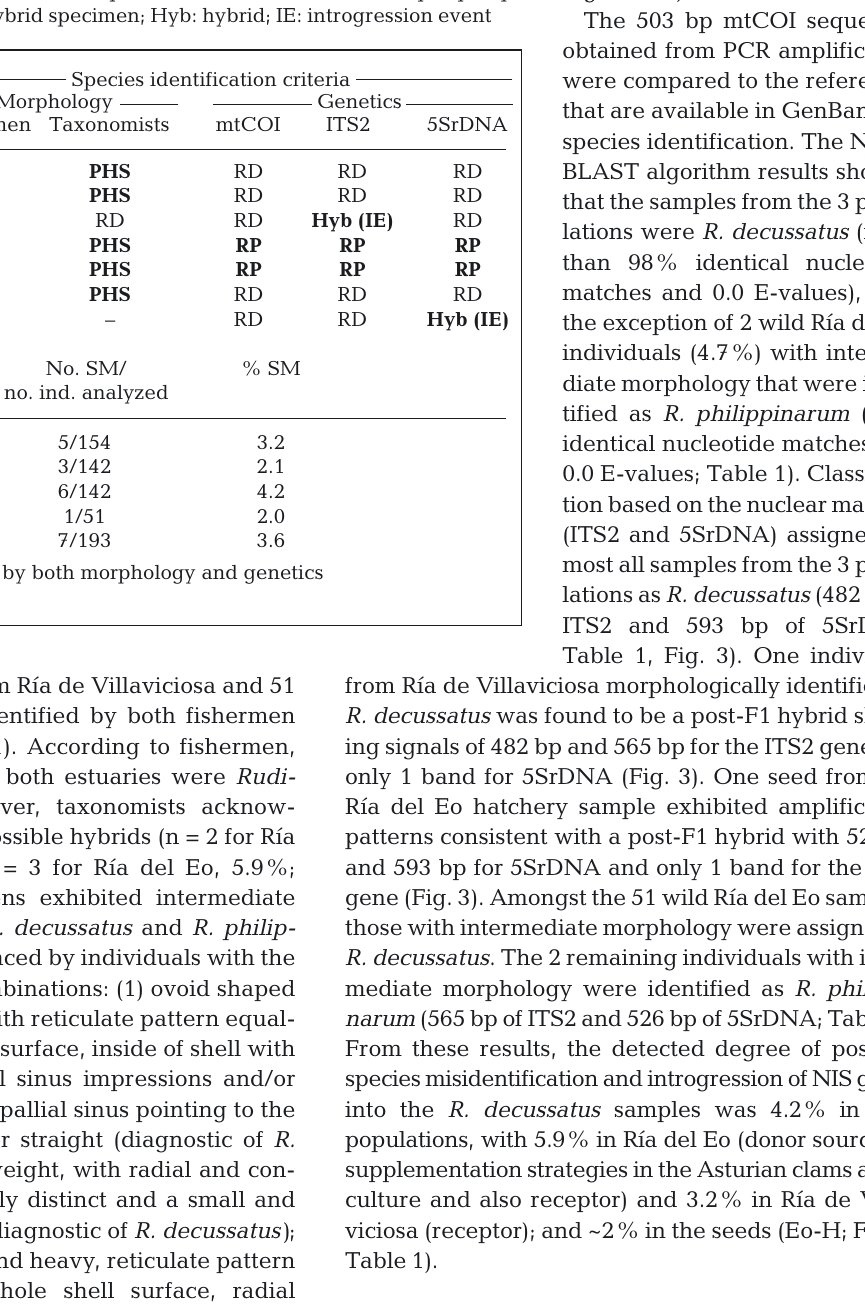
Table 1. Cases of possible species misidentifications (SM) by fishermen detected in individuals from wild (W) and cultured hatchery (H) populations of the